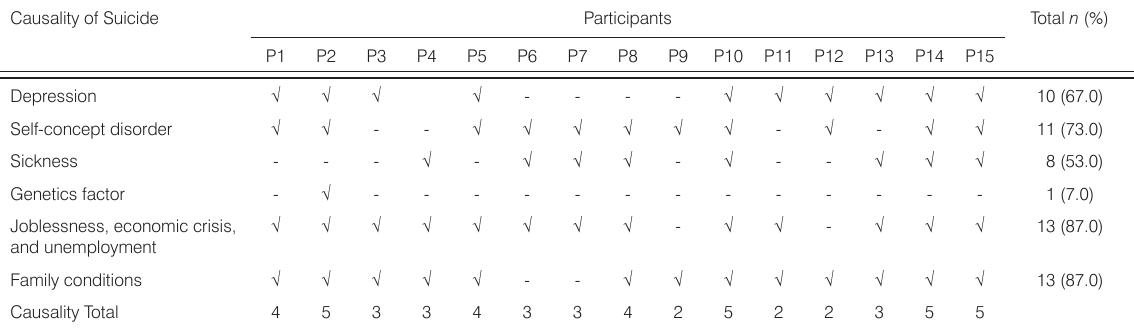
Table 2. The causality of suicide attempts